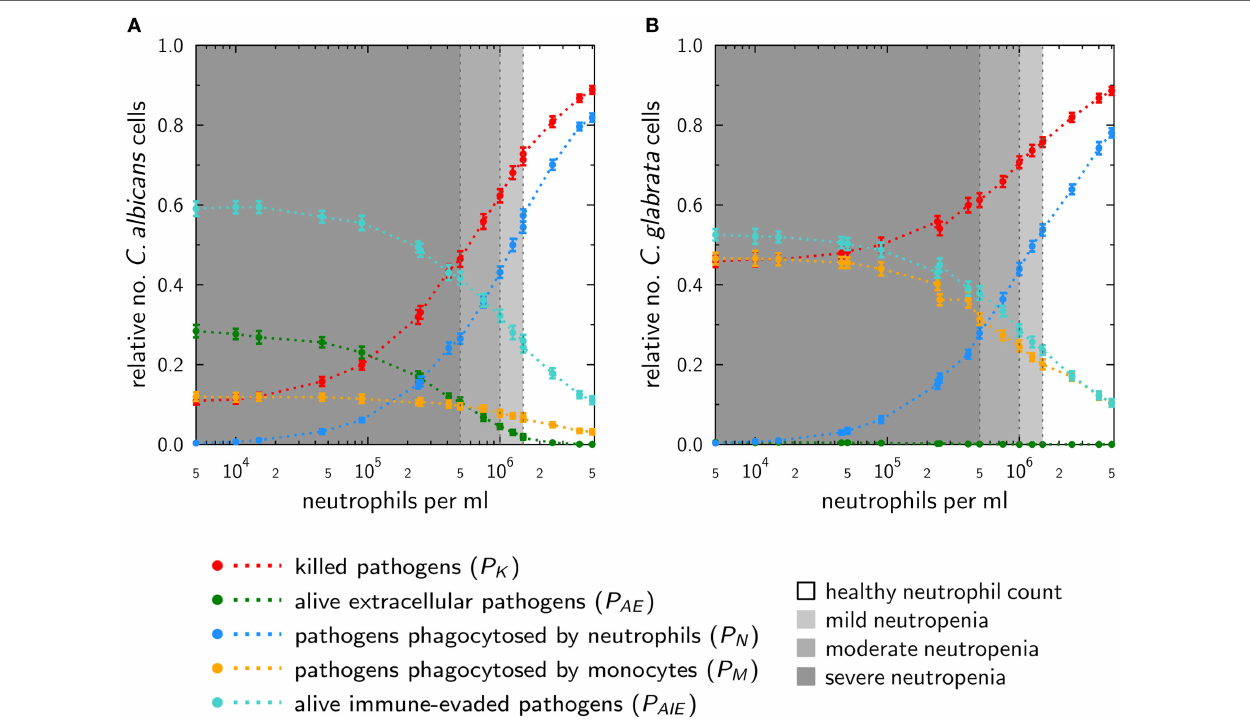
FIGURE 5 | In silico infections under neutropenic conditions with Candida albicans (A) and Candida glabrata (B) were performed by gradually decreasing the absolute neutrophil count in the agent-based model. Plots show the fraction of killed cells (red), alive and extracellular cells (green), phagocytosed cells by neutrophils (blue), and monocytes (yellow) as well as (alive) cells that are able to evade the immune system (turquoise) at 4h post